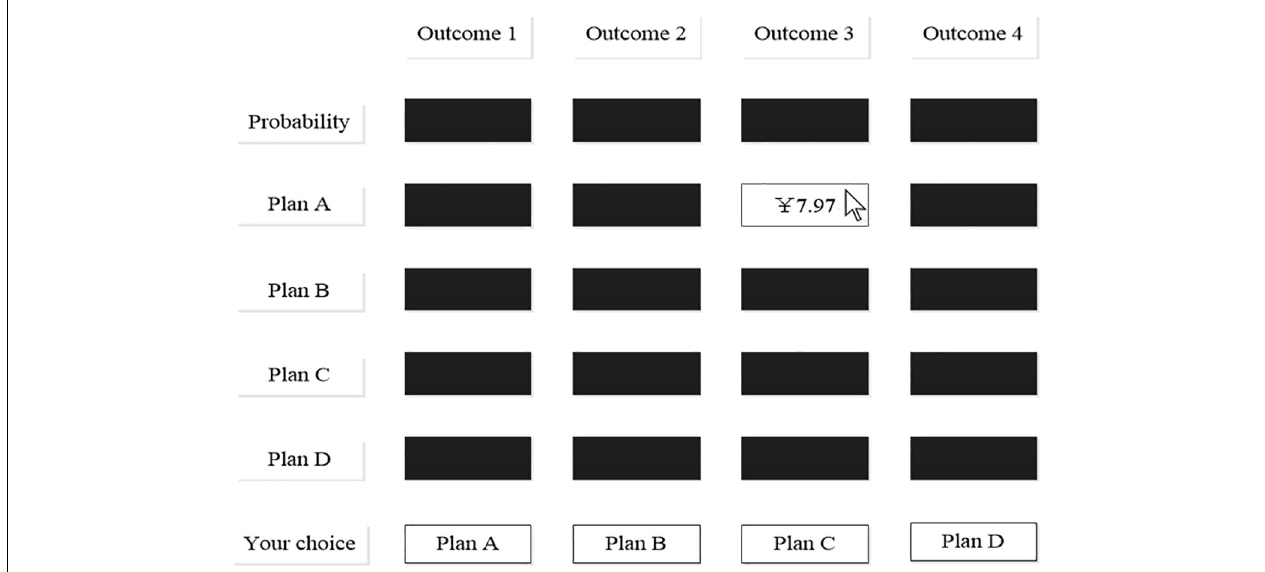
FIGURE 1 | Gamble game using a process-tracing